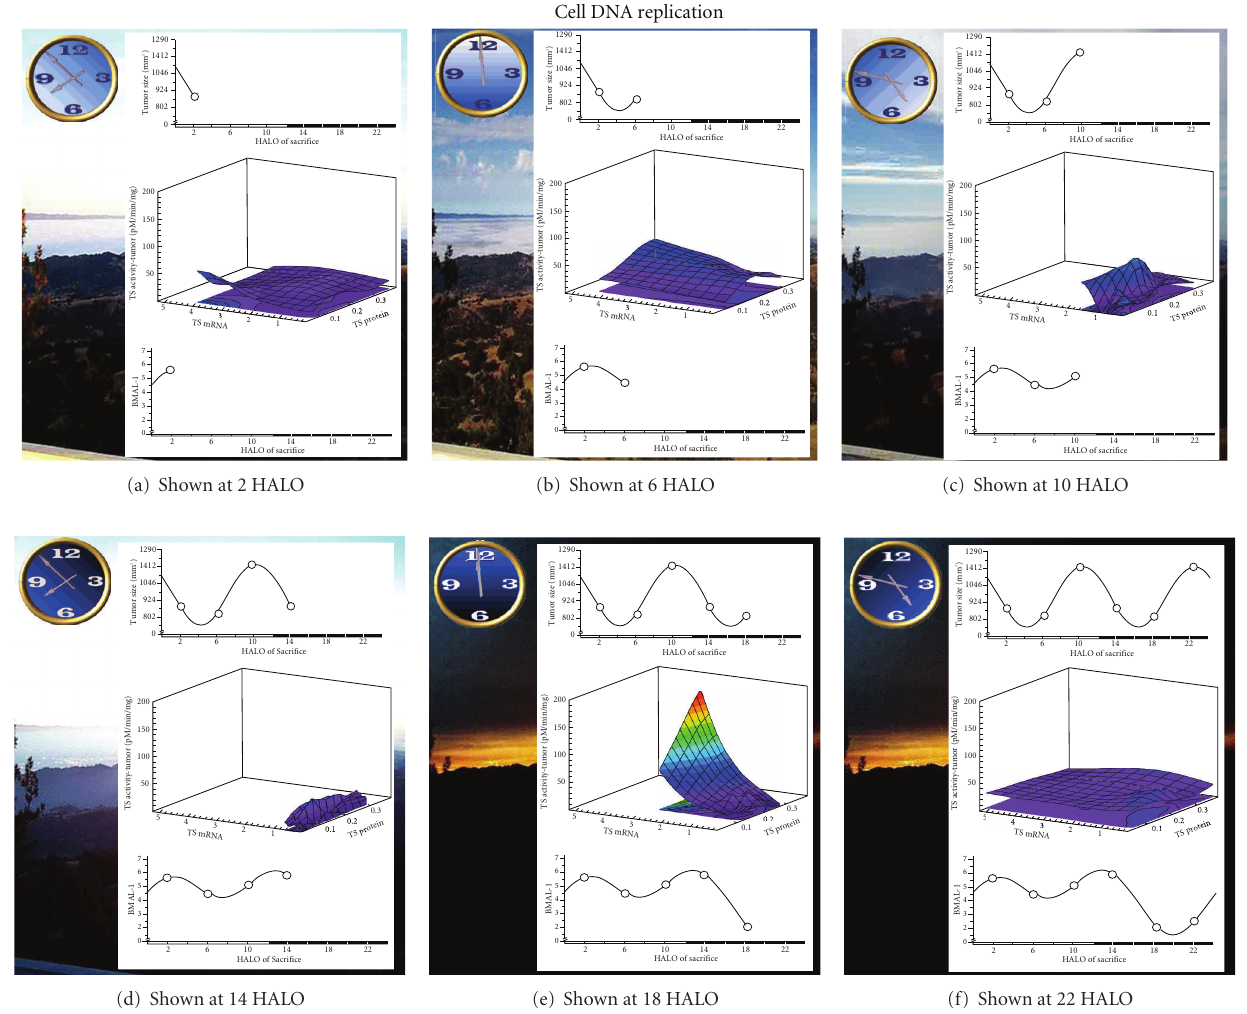
Figure 1: Snapshot of Supplementary Movie 1. The cytotoxicity of 5-FU (5 Fluorouracil), an agent targeting thymidylate synthase (TS), is greatest when TS activity is the lowest. Both message and protein are necessary precursors for TS enzyme activity. Average tumor size is the lowest between 2 and 6 Hours After Lights On (HALO) when TS message and protein are both present. TS activity rises modestly as tumor size increases. TS message then fades as TS protein persists, TS activity declines and tumor size decreases. TS activity then spikes followed by tumor size and TS activity recession with residual TS message and protein. Times of day associated with the lowest tumor cell enzyme activity are the times of day associated with greatest 5-FU tumor cell anticancer activity. Times of day associated with highest tumor cell TS activity correspond to times of day of greatest tumor cell resistance to the cytotoxic e ff ects of 5-FU. Tumors can thereby be expected to be most resistant to 5-FU in the middle of the daily dark/activity span (18 HALO) and most sensitive to 5-FU in the middle of the daily light/sleep